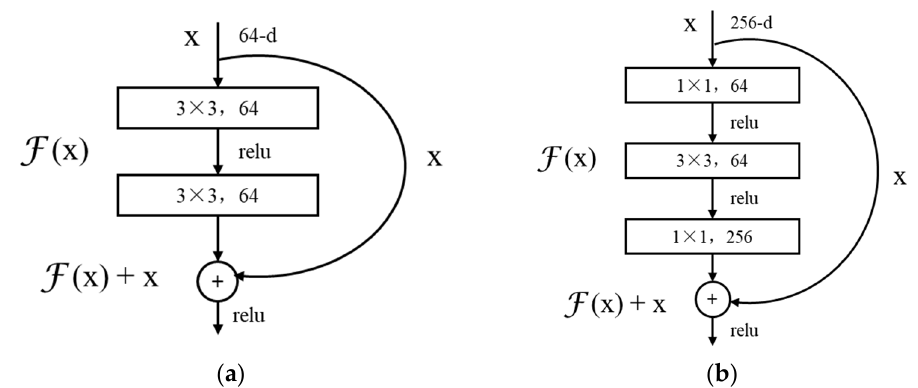
Figure 4. Structure diagram of the residual block. ( a ) Residual block in ResNet-18/34. ( b ) Bottleneck layer in ResNet-101/152.